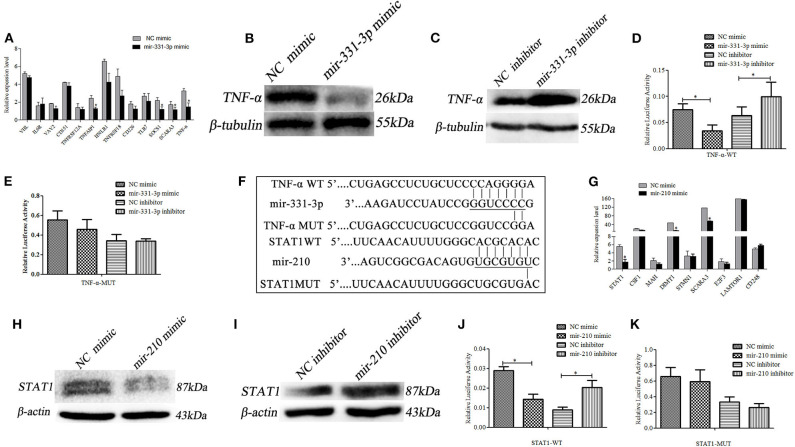
Mir-331-3p and mir-210 regulate target genes TNF-α and STAT1, respectively. Marc-145 cells were transfected with mir-331-3p to detect the expression of the potential target genes (A). TNF-α expression was detected by western blot in Marc-145 cells transfected with mir-331-3p mimics (B) or mir-331-3p inhibitor (C). The dual luciferase reporter assay was used to verify the bind of mir-331-3p and TNF-α in cells co-transfected with mir-331-3p mimics/inhibitor and TNF-α-WT (D) or TNF-α-MUT (E). Bioinformatical predication showed that TNF-α and STAT1 were the target gene of mir-331-3p and mir-210, respectively (F). Marc-145 cells were transfected with mir-210 mimics to detect the expression of the potential target genes (G). STAT1 protein expression was detected by western blot in Marc-145 cells transfected with mir-210 mimics (H) or mir-210 inhibitor (I). The dual luciferase reporter assay was used to verify the bind of mir-210 and STAT1 in cells co-transfected with mir-210 mimics/inhibitor and STAT1-WT (J) or STAT1-MUT (K). All values represent the mean ± s.d. of three independent experiments. *p < 0.05.